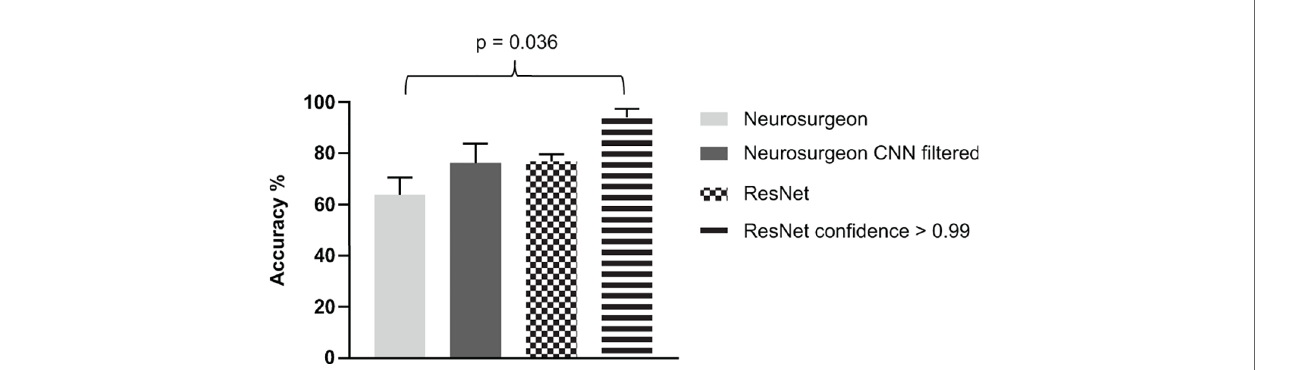
FIGURE 3 | Comparative analysis of manual, deep learning based and combined assessment of glioblastoma, brain metastasis and meningioma images obtained by confocal laser endomicroscopy. Balanced test sets containing 90 images were anonymized and evaluated by trained neuro-oncological surgeons. Results are displayed in the fi rst column. A second test set was evaluated by the surgeons including images rated by the residual network with a con fi dence of 0.99 or higher (2nd column). Overall accuracies of residual network test set analysis and results of the image subgroup rated with an output level of 0.99 or higher are displayed. Average accuracy of at least three independent experiments and fi ve-fold cross validation are shown,